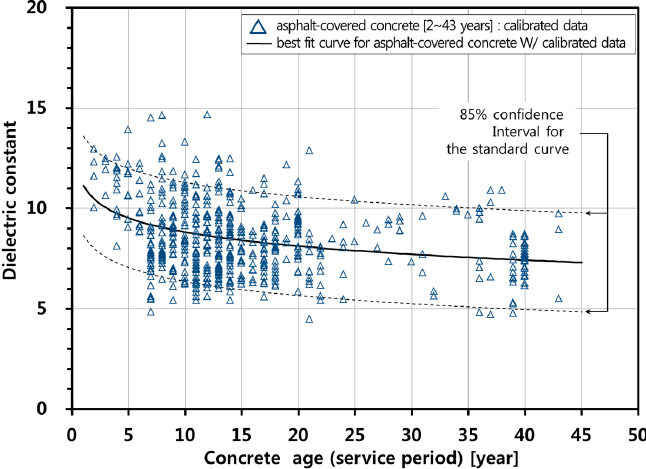
Figure 8. Proposed standard curve representing the relationship between the dielectric constant of concrete bridge deck and concrete age (service year).